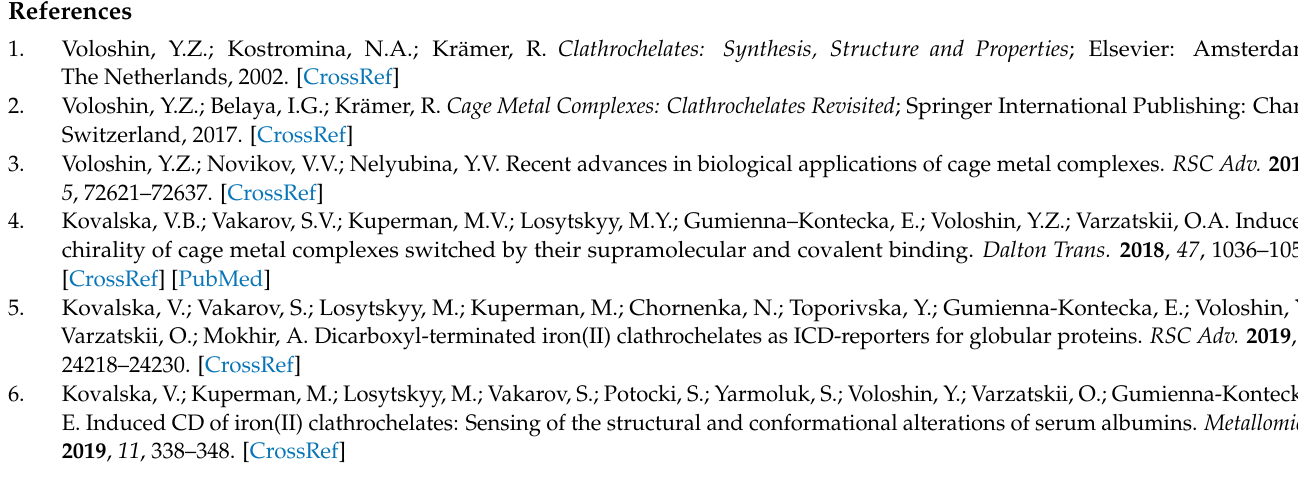
Figure S32. Fragment of MALDI-TOF spectrum of the dicarboranoclathrochelateFeBd2(Gm(SpCarb)2)(BF)2. Table S1: Maxima (nm) and intensities ( ε × 10 − 3 , mol − 1 L cm 3 ) of the bands in the UV–vis spectra of the dichloromethane solutions of the iron(II) complexes under study and those in the spectrum of THF solution of its organic carborane-based